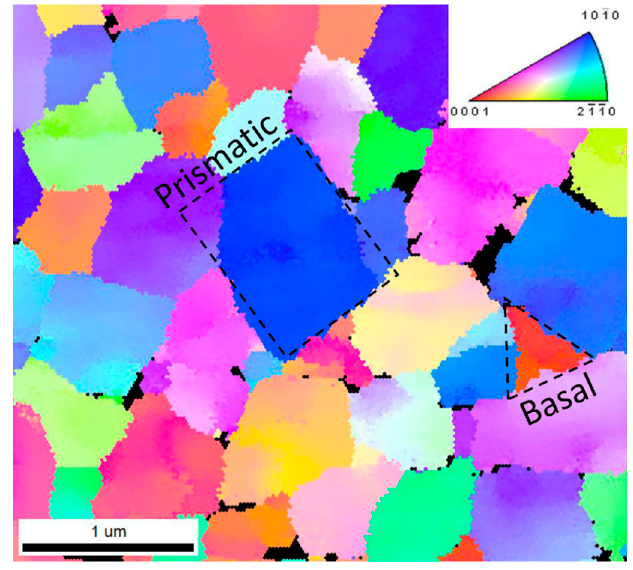
Figure 2. EBSD inverse pole figure (IPF) of the WC-Co microstructure after chemomechanical polishing.